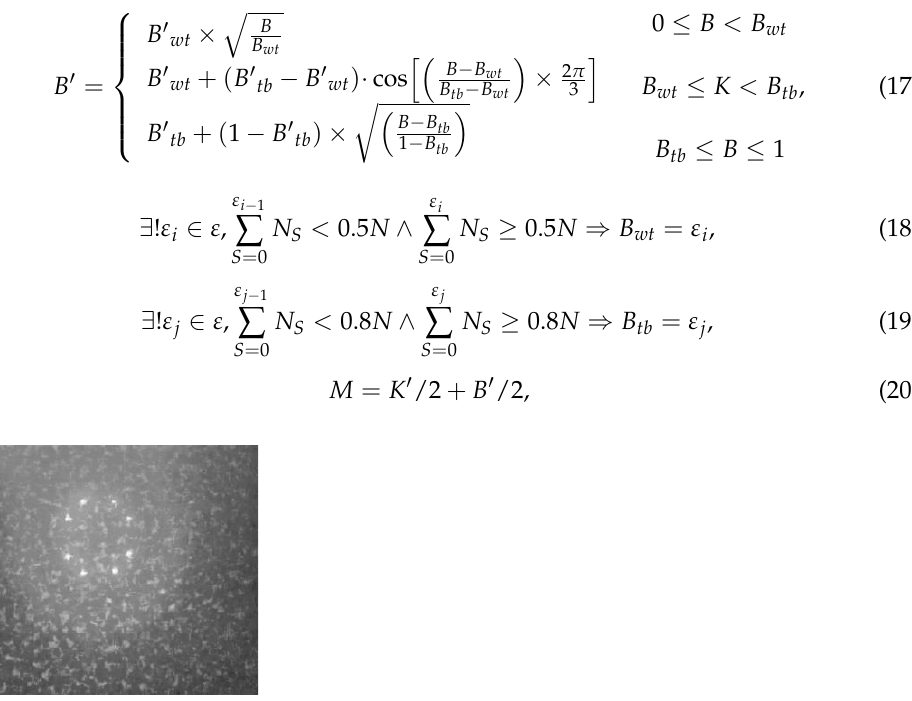
Figure 13. Result from segmentation.